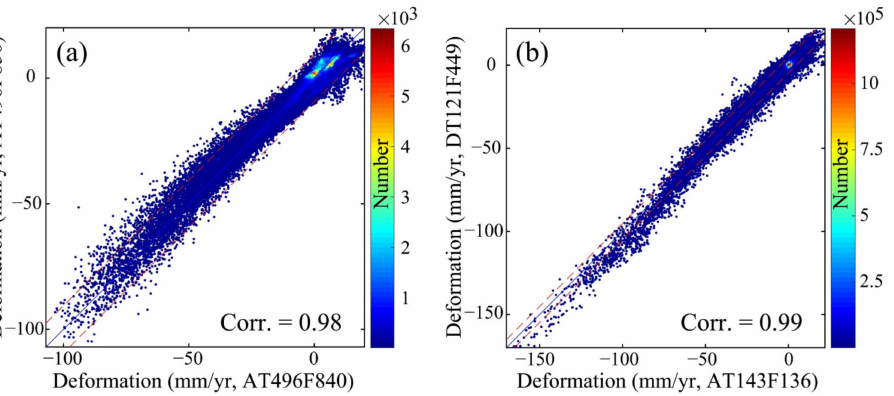
Figure 7. Comparison between the results obtained by ( a ) ALOS-1/PALSAR AT496F840 and AT496F850 data, and ( b ) the Sentinel-1 AT143F136 and DT121F449 data. The red dotted lines denote the value three times the root-mean-square